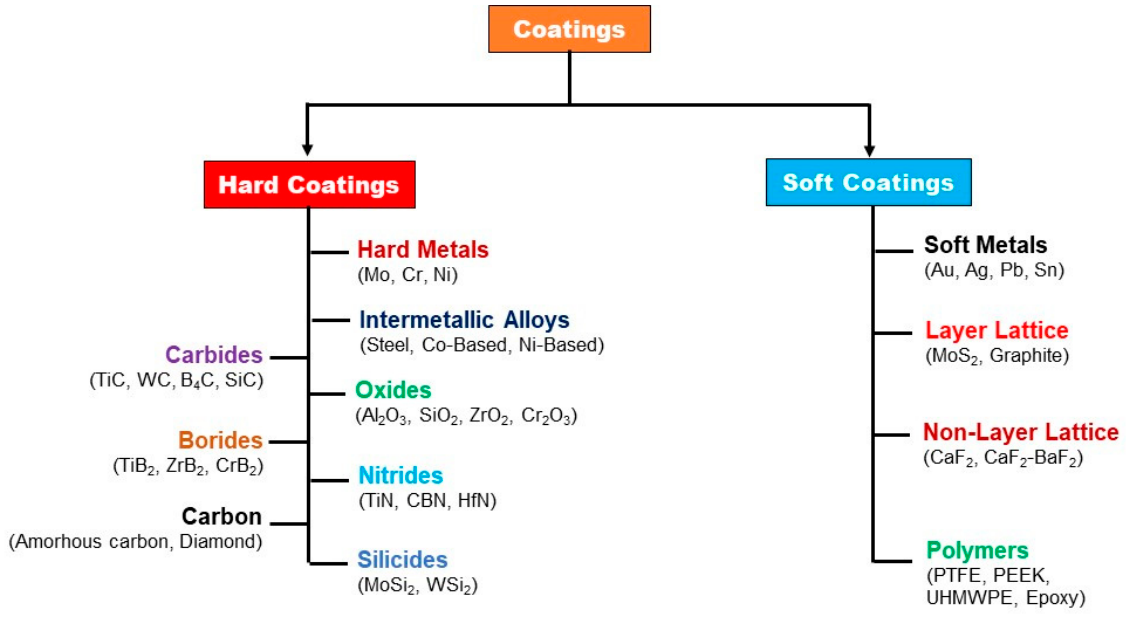
Figure 1. Classification of different types of coatings. Table 1. Properties of common thermoset resins.